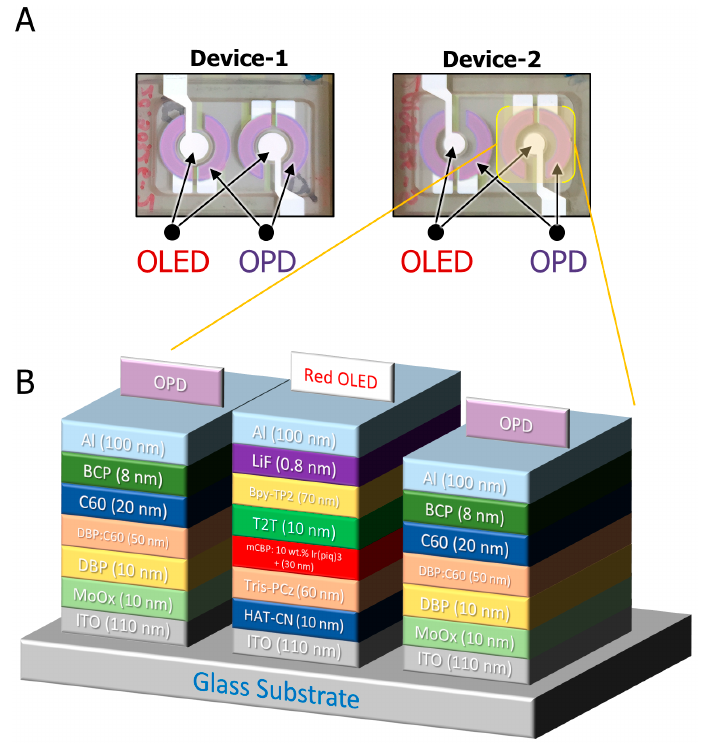
Figure 5. ( A ) The fabricated organic biosensor pulse meter for Device-1 and Device-2. ( B ) A cross-section of the organic material structure of the OLED and OPD for both devices.